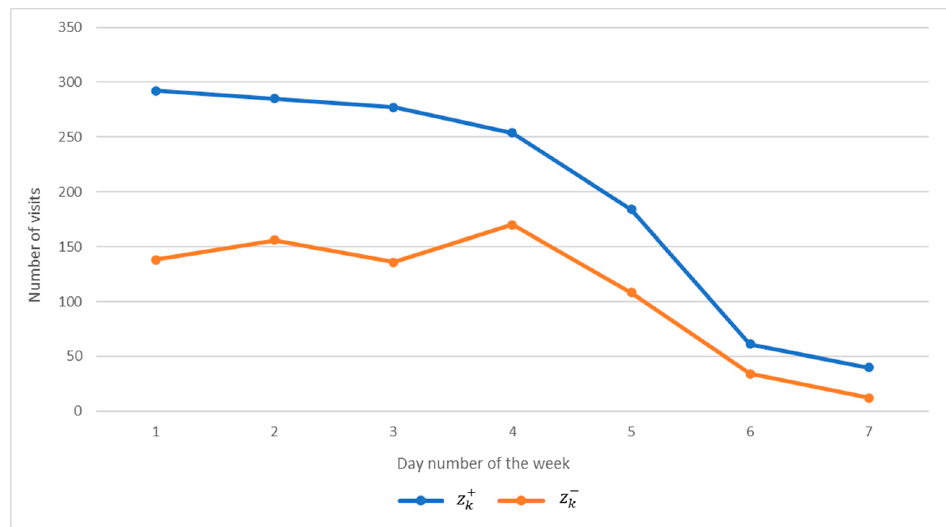
Figure 1. Fragment of the activity schedule.